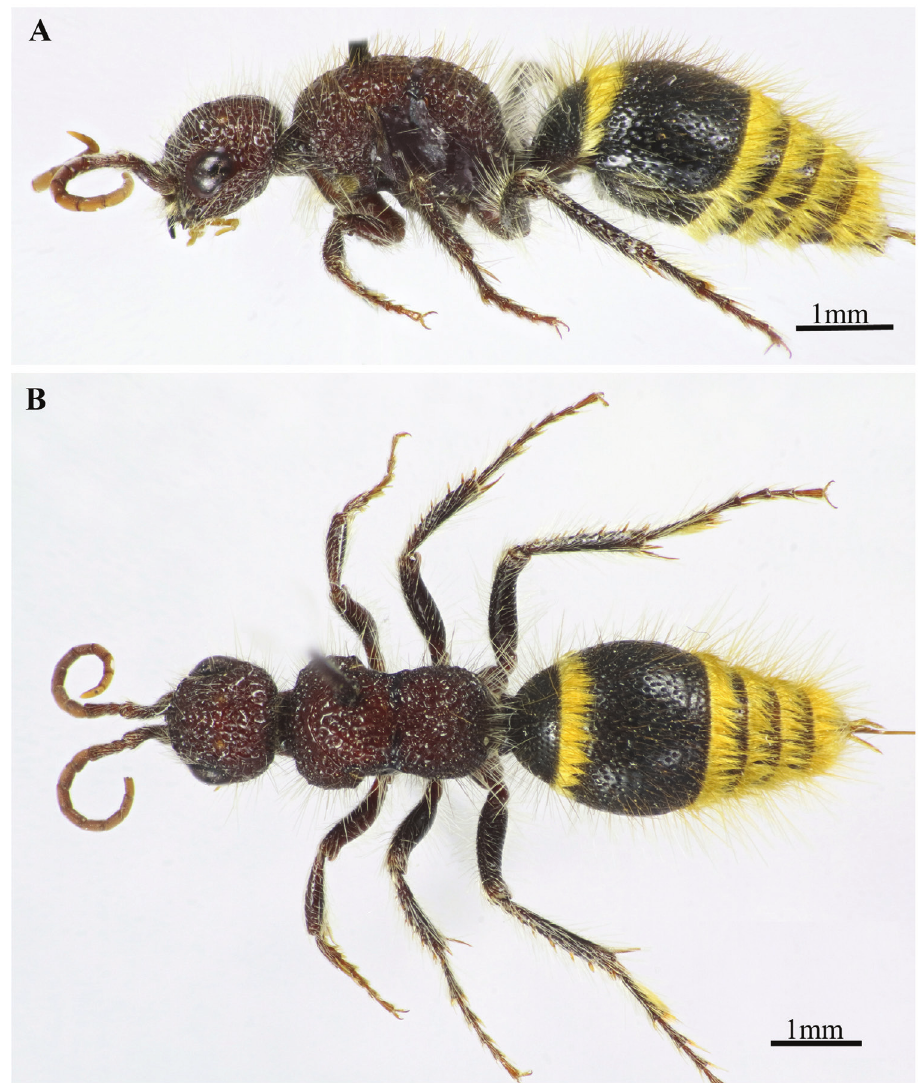
Figure 18. Pseudophotopsis mascatiana Invrea (Female) A, B habitus, lateral and dorsal views, respectively.